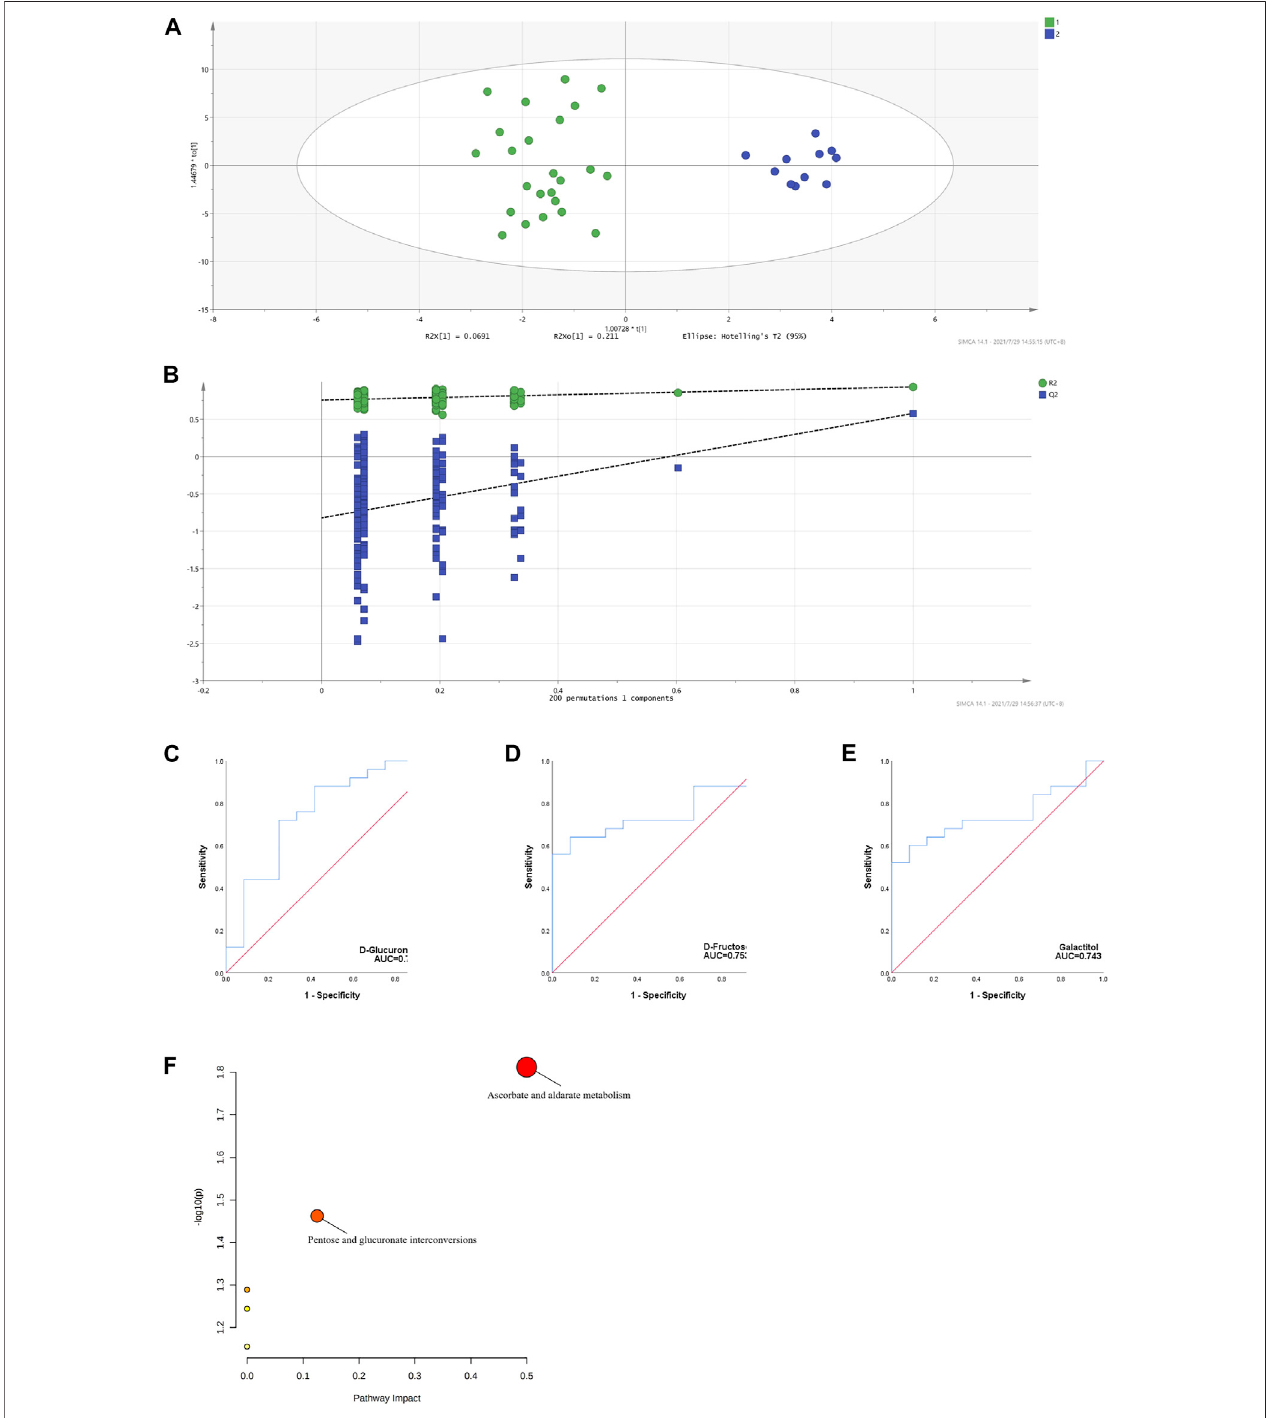
FIGURE 4 | OPLS-DA model based on the data from the cITP patients grouped by (H) pylori infection (A) score scatter plot (B) 200 random permutation tests (C – E) ROC of the three distinct metabolites with biomarker potential (F) MetPA of the three distinct metabolites in cITP patients grouped by (H) pylori infection.